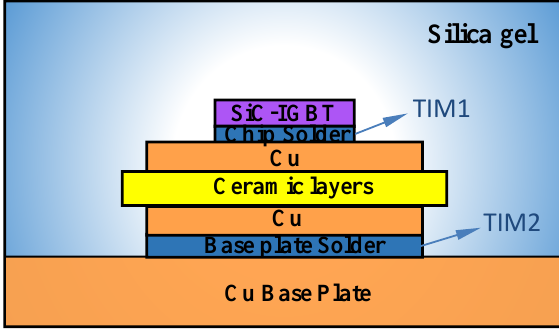
Figure 1: IGBT power module package structure